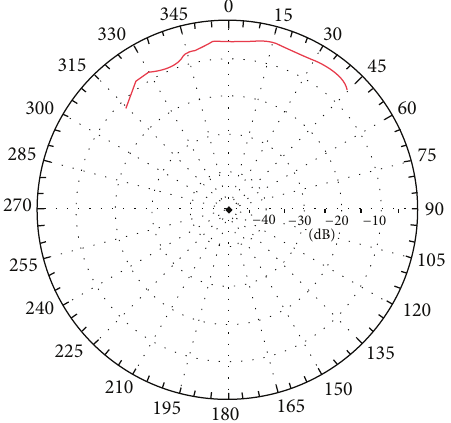
Figure 12: Vertical cut of 3D measured radiation pattern at 8GHz. Table 2: Antenna parameters comparison.